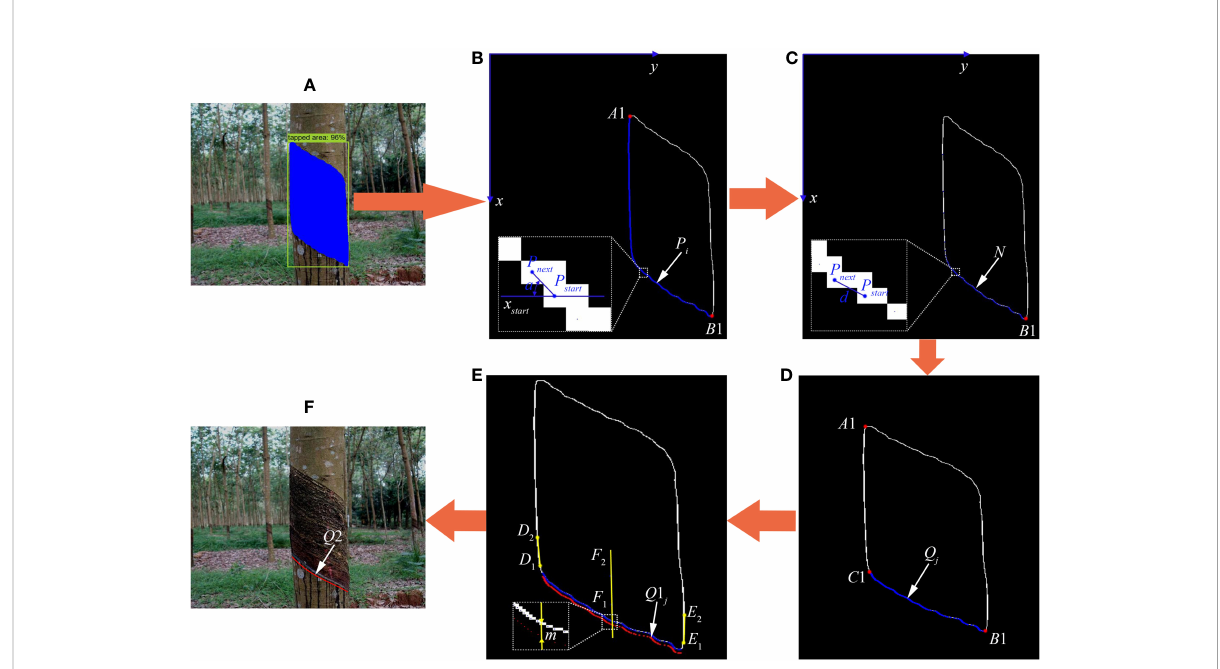
FIGURE 5 Fine segmentation of existing tapping line and location process of new tapping line. (A) Prediction image. (B, C) Edge line images of tapped area of natural rubber tree. (D) Existing tapping line image of natural rubber tree. (E) Schematic diagram of position calculation of new tapping line. (F) New tapping line image of natural rubber